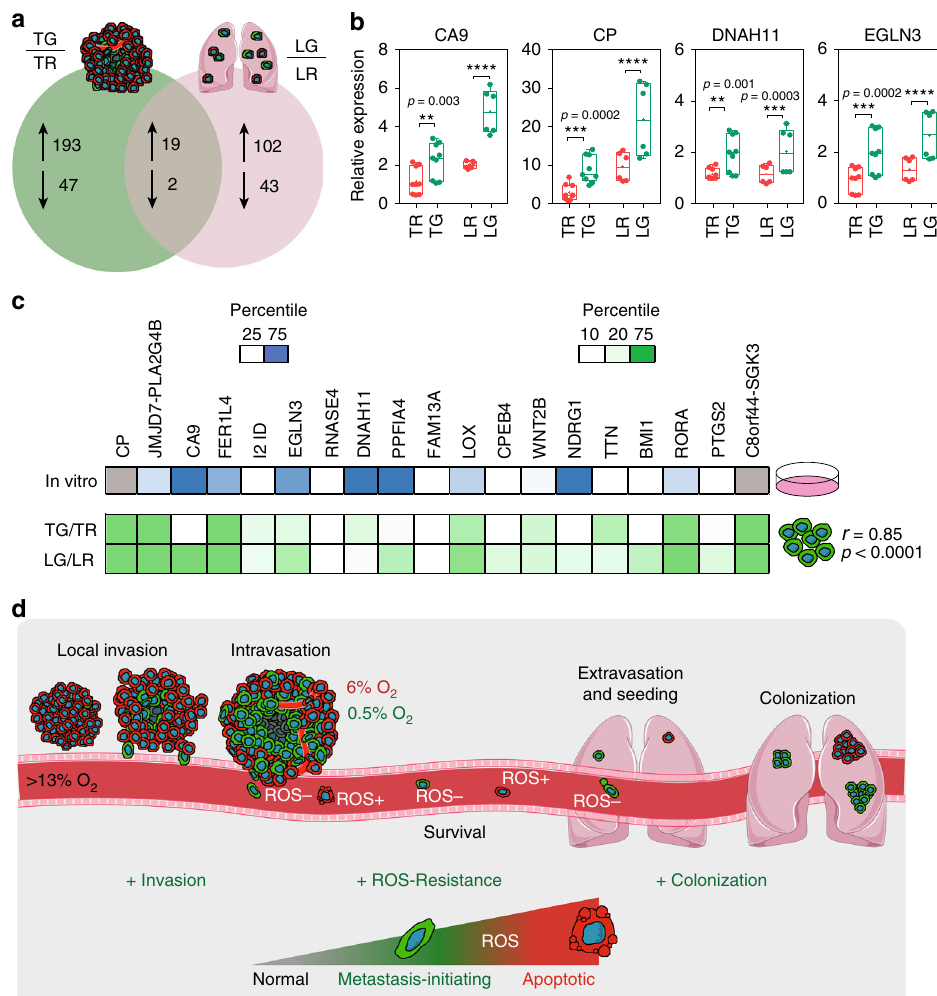
Fig. 9 Post-hypoxic ‘ memory ’ at the metastatic site. a Venn diagram displaying the overlap of the number of genes with differential expression ( − 1.5 ≥ FC ≥ 1.5) in GFP + (TG) versus DsRed + (TR) tumor cells (green circle) and GFP + (LG) versus DsRed + (LR) metastatic cells in the lung (pink